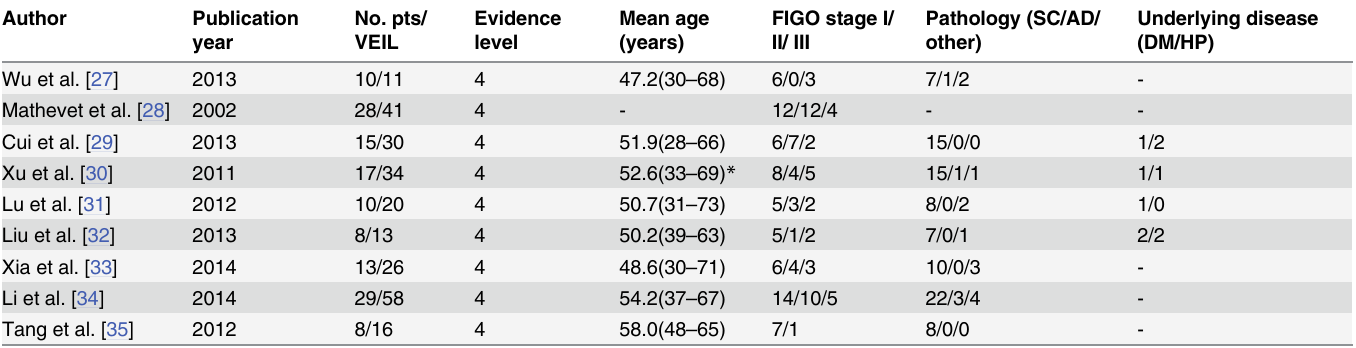
Table 1. Characteristics of the Included